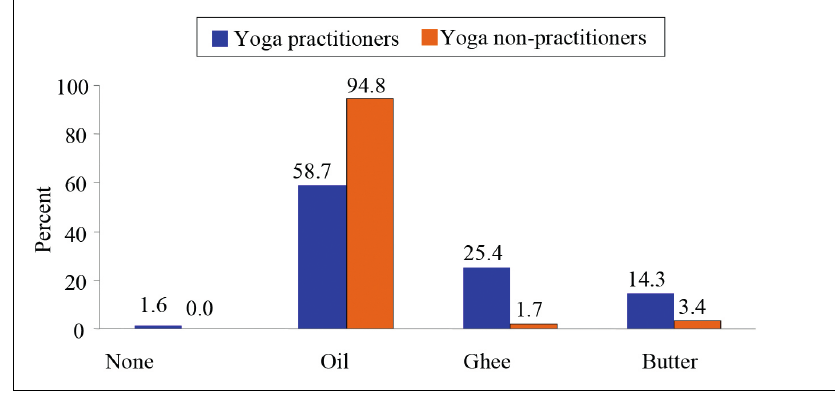
Figure 5. Pattern of fruit intake in women yoga practitioners and non-